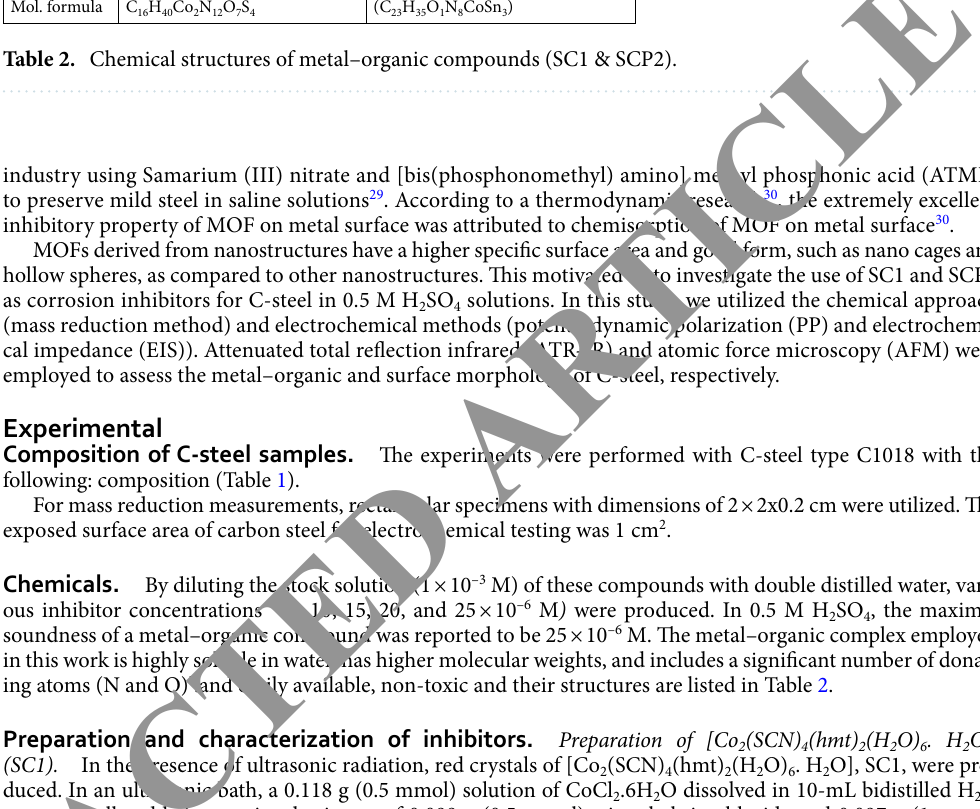
Compound SC1 SCP2